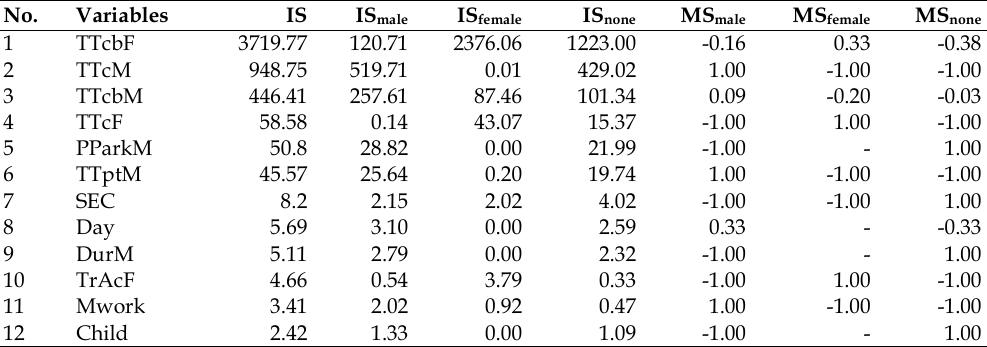
Table 9. Impact Table of Condition Variables of Car Allocation Model